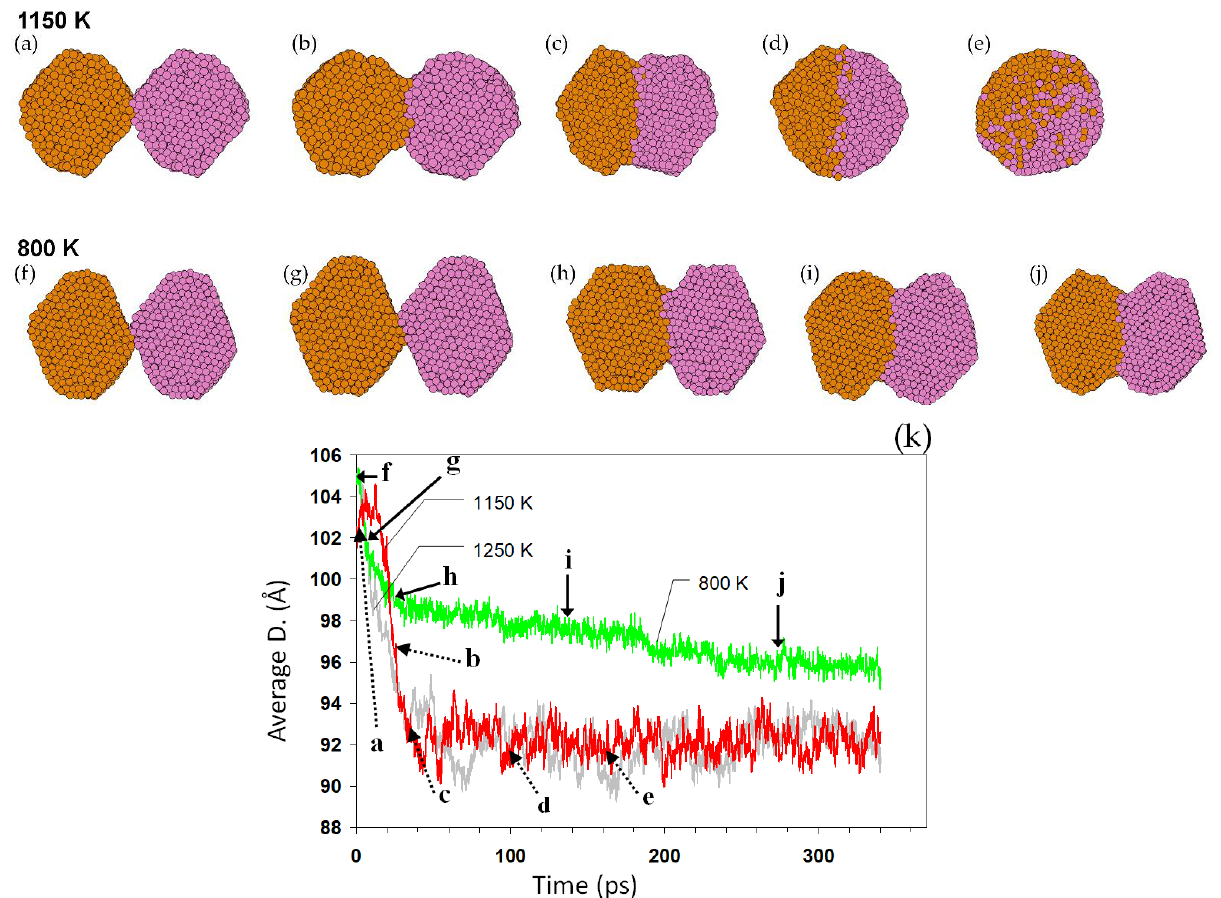
Figure 5. The evolution of coalescing nanoparticles. The snapshots of the coalescence of two pairs of identical 2406 nanoparticles at initial temperatures ( a – e ) 1150 K and ( f – j ) 800 K are shown. Cross- sectional views of nanoparticles are shown. The size evolution and the corresponding size/time of the snapshots are shown in ( k ): a – j in this plot correspond to subfigures ( a – j ). The size evolution for two liquid nanoparticles at 1250 K is also shown for comparison.